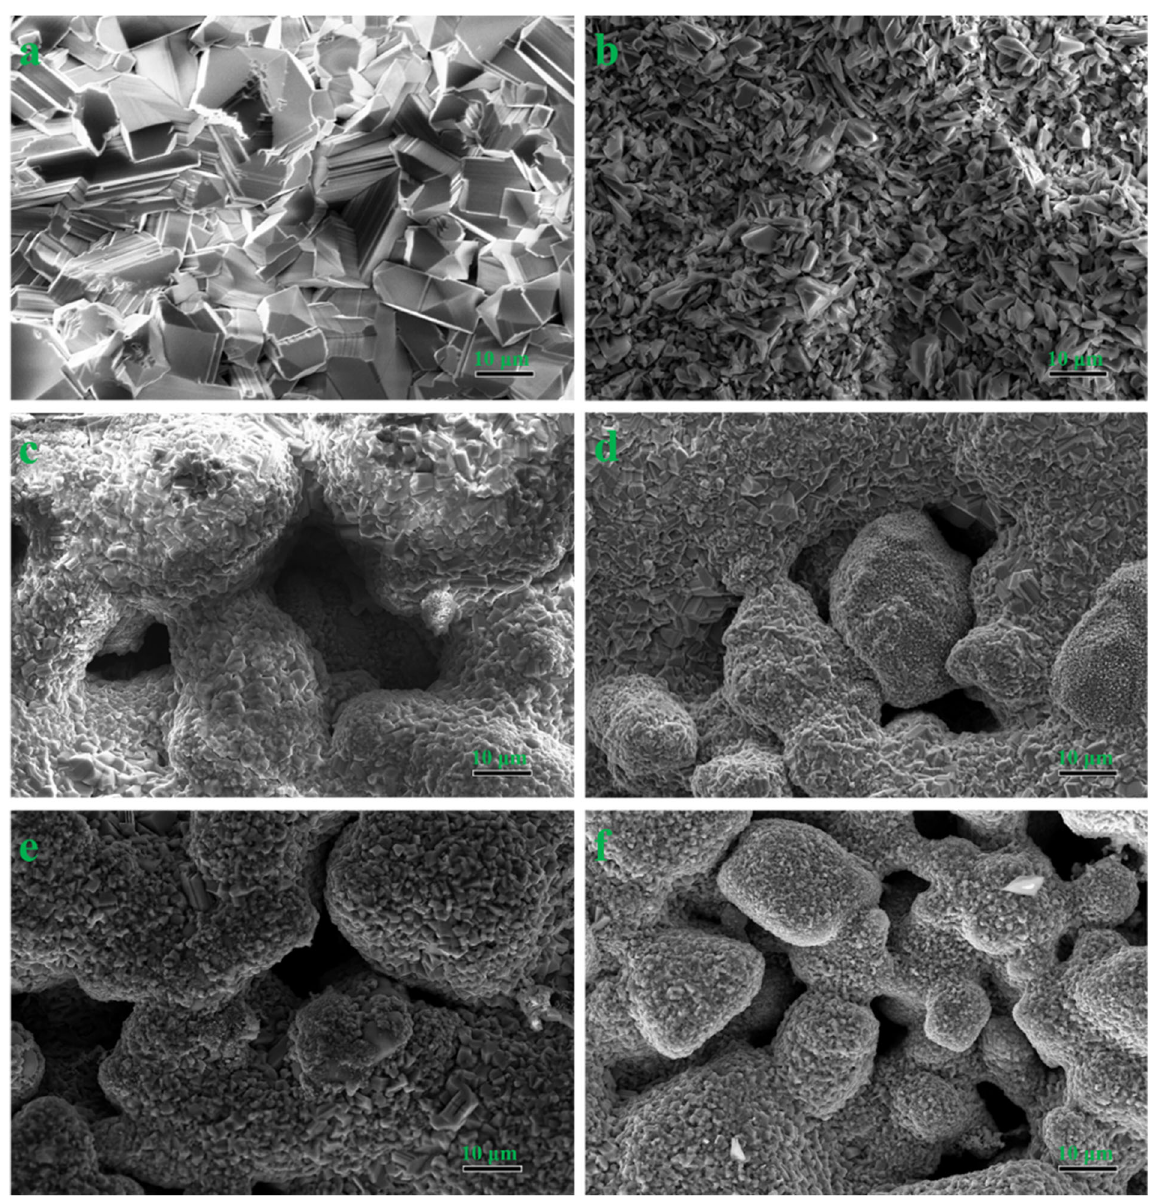
Fig. 8 FESEM images of porous materials treated by isothermal oxidation and isothermal sul fi dation. a , b Ti-48Al porous alloy; c , d Ti-48Al- 6Nb porous alloy; e , f PCMM with 4 wt.% Nano-ZrO 2 .